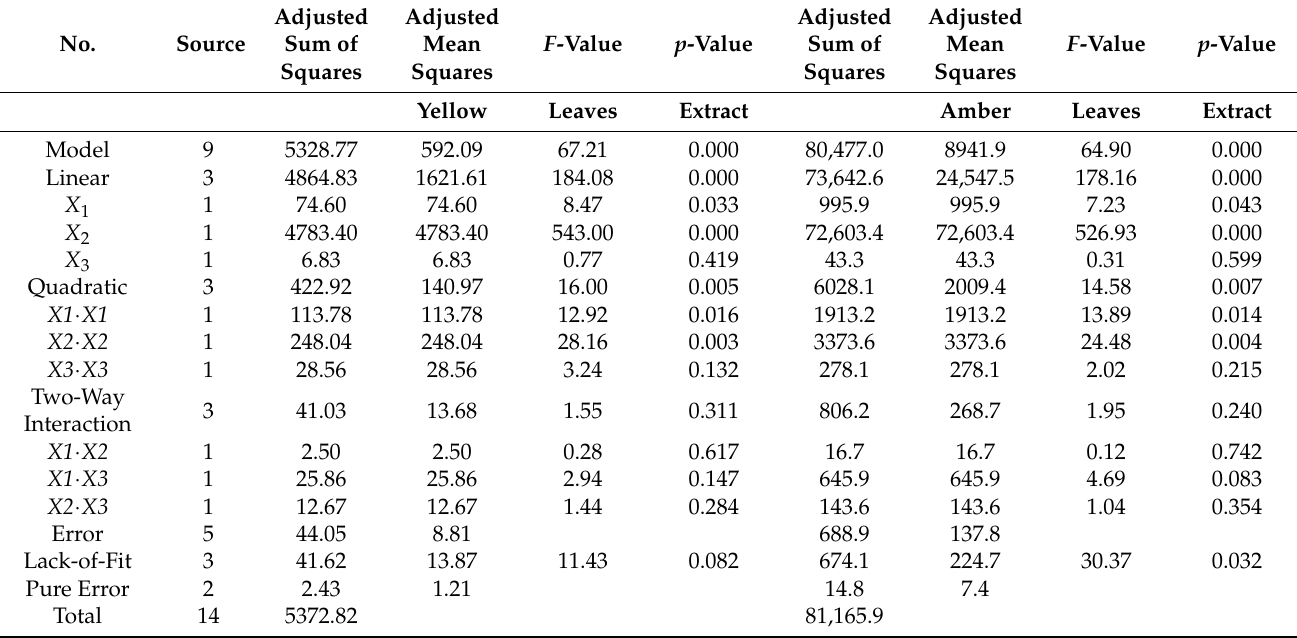
Table 5. The analysis of variance for the α -tocopherol relative amount in P. persica yellow leaves and amber